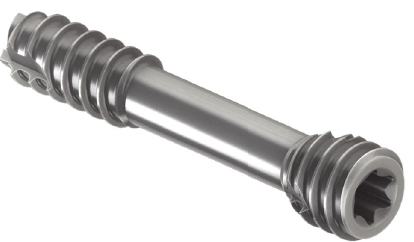
Figure 1: The compression screw MAGNEZIX CS resembles a cannulated conventional compression screw. However, it is made of a completely bioabsorbable magnesium alloy (MgYREZr).